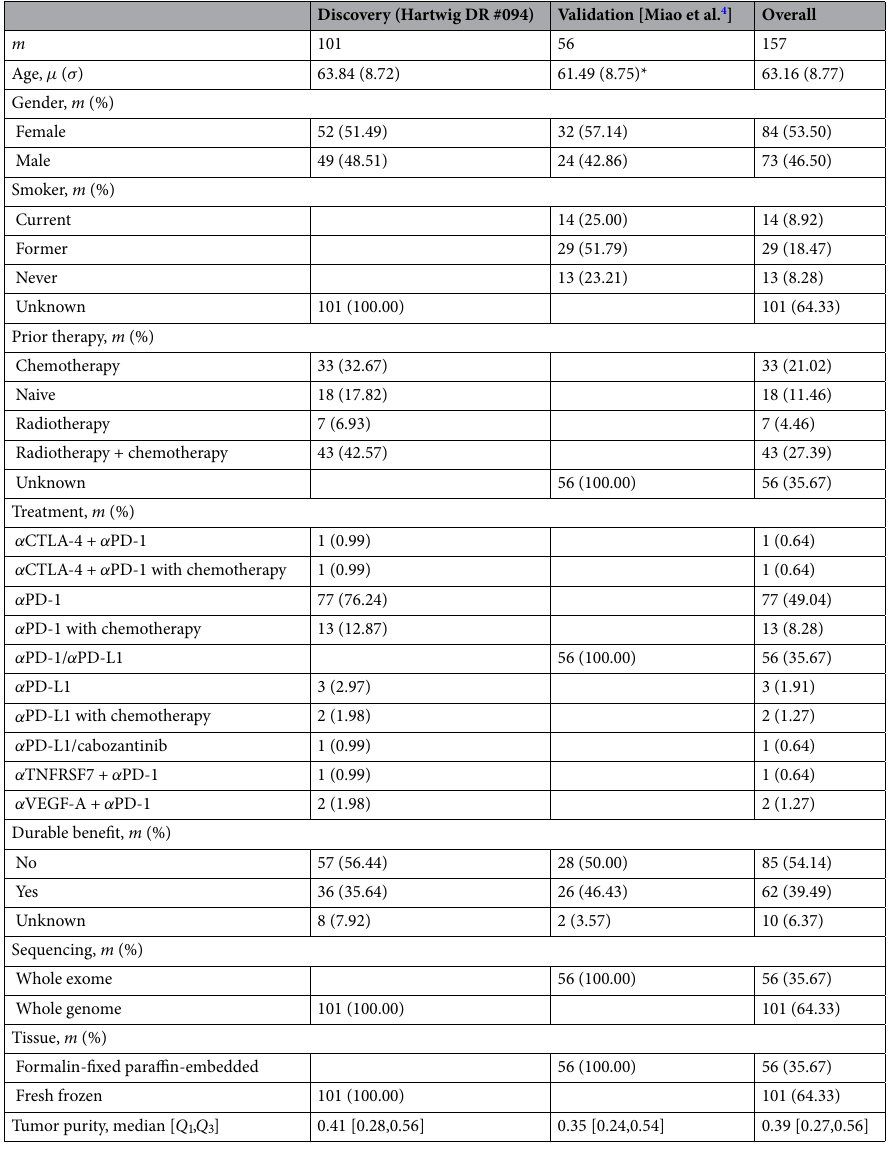
Table 1. Patient characteristics and outcome of advanced non-small cell lung cancer. Symbols and abbreviations: α CTLA-4, cytotoxic T lymphocyte-associated antigen-4 inhibitor; α PD-1,